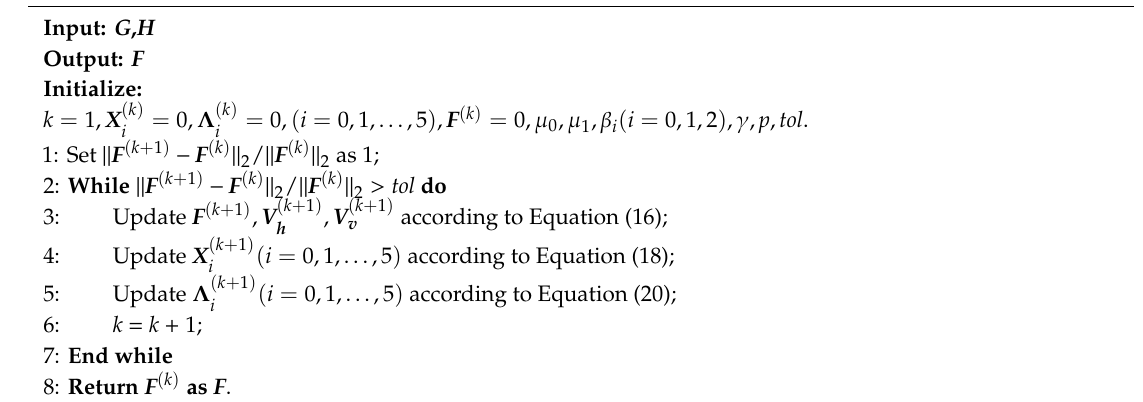
Algorithm 1. Pseudocode TGV_Lp for image